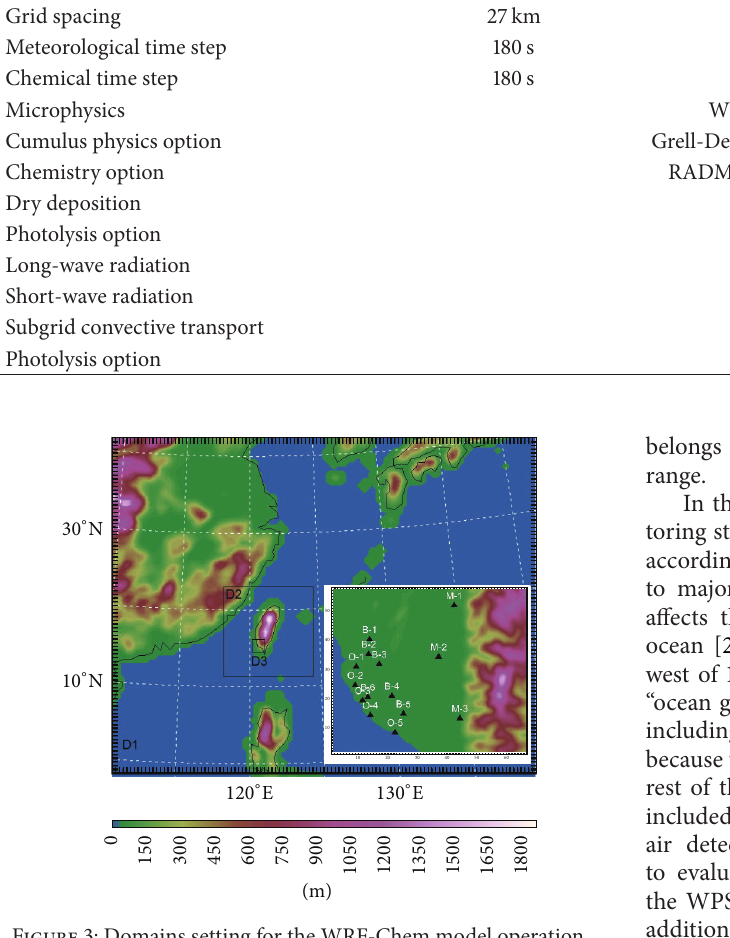
Figure 3: Domains setting for the WRF-Chem model operation.